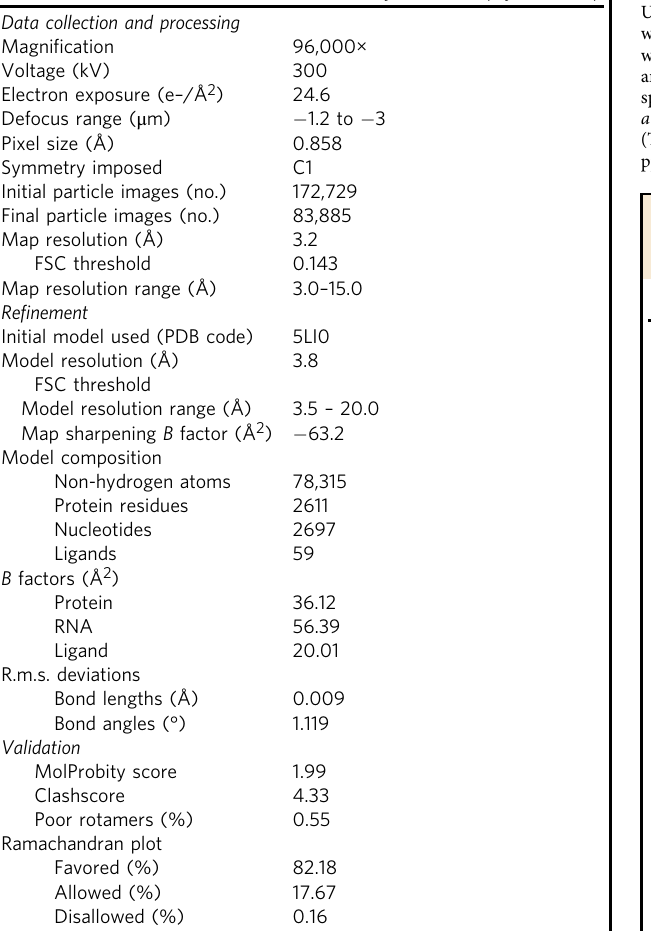
Table 1 Cryo-EM data collection, re fi nement, and validation statistics.